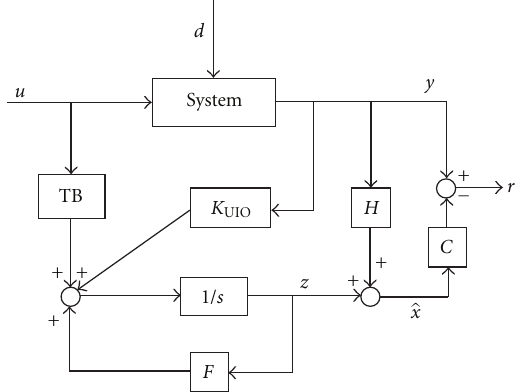
Figure 4: Structure of unknown input